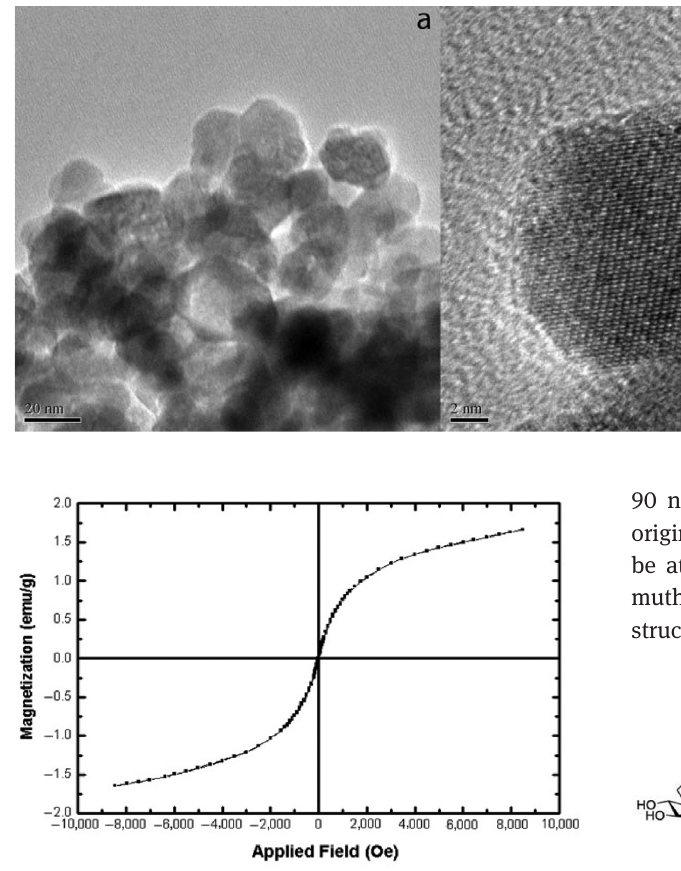
Figure 8: M – H hysteresis loops of the bismuth ferrite nanoparticles synthesized by Pechini method.